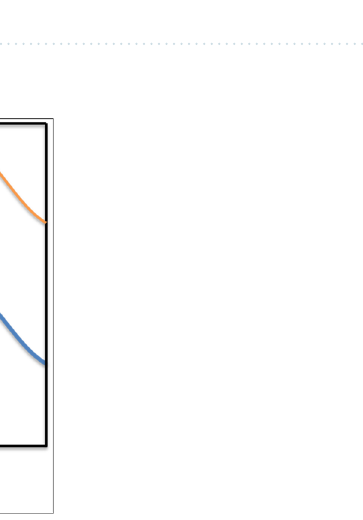
Table 3. Alpha helical content and other parameters for secondary structure estimation of BSA and BSA with MiADMSA.